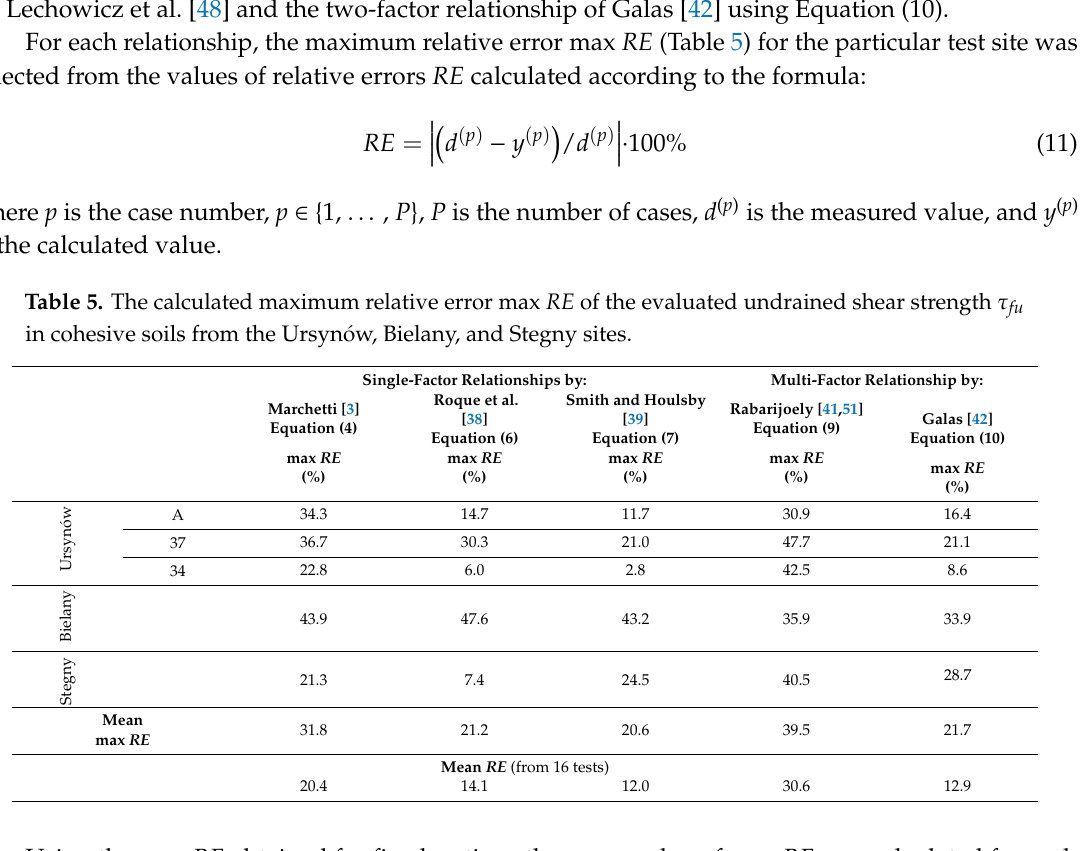
Table 5. The calculated maximum relative error max RE of the evaluated undrained shear strength τ fu in cohesive soils from the Ursyn ó w, Bielany, and Stegny sites.